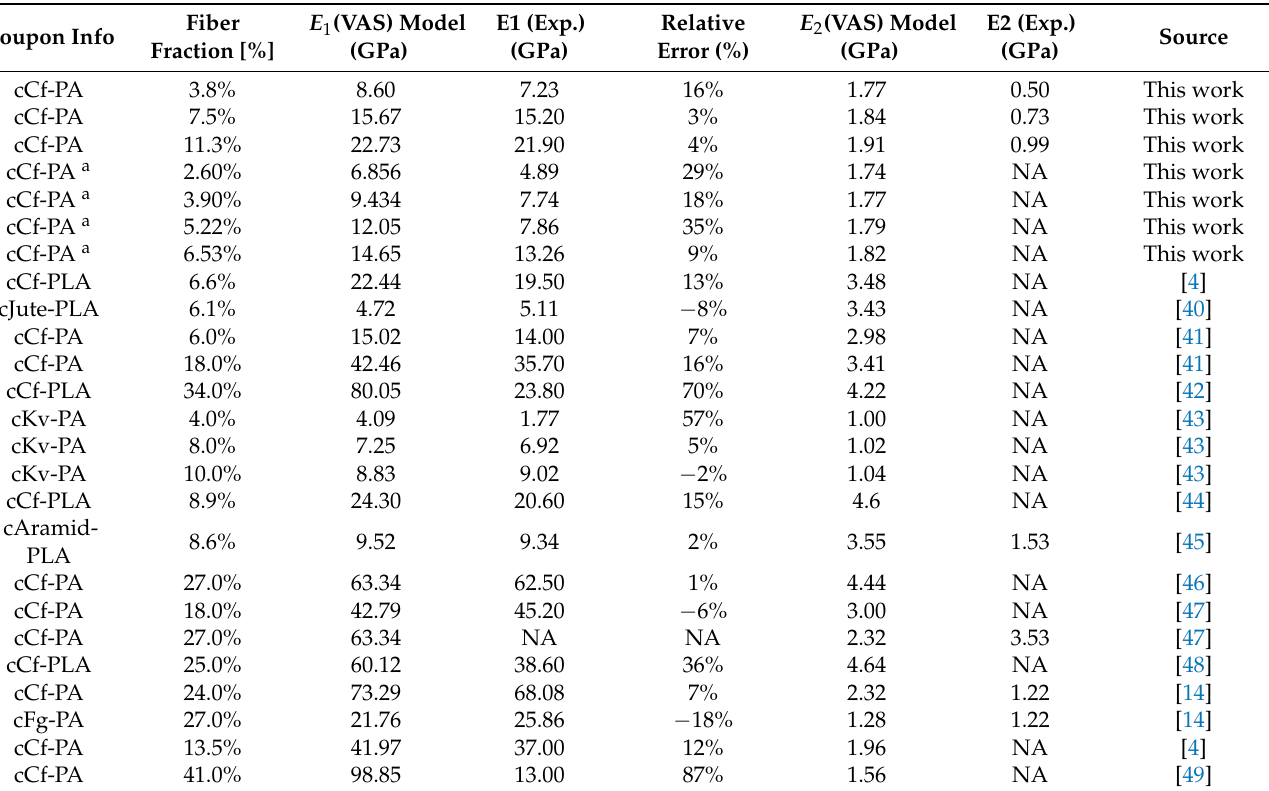
Table 3. Longitudinal and transversal modulus comparison: experimental and micromechanics formulation for various